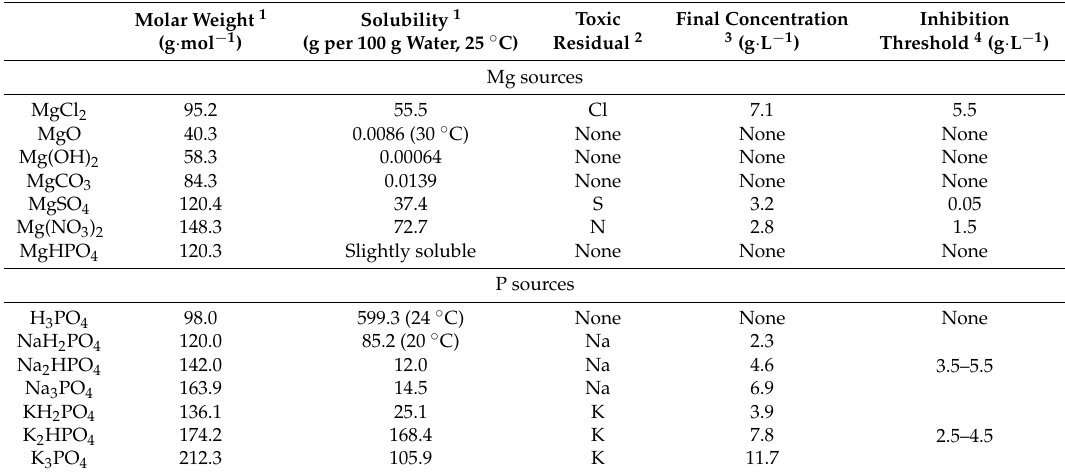
Table 1. Magnesium and phosphorus sources potentially used in struvite precipitation.